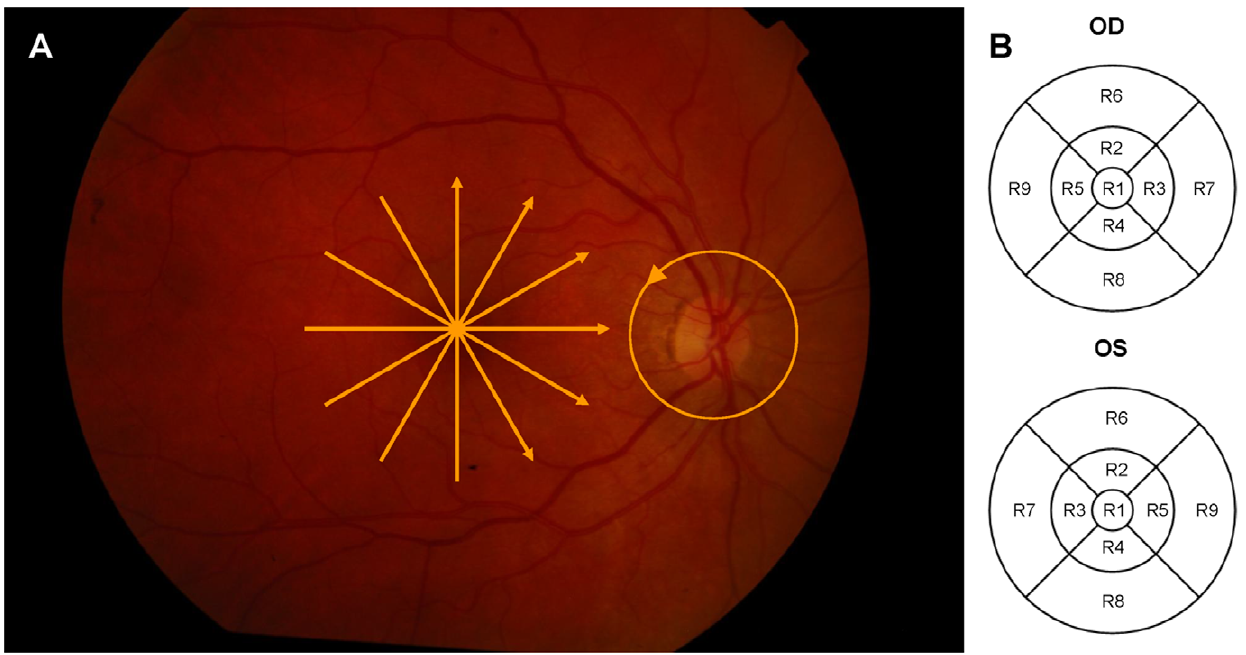
Figure 1. Retinal scanning used in the study. The yellow arrows in the macula and the circle around the optic nerve head show the locations of the OCT scans made. (B) The distribution of ETDRS regions for the right (OD) and left eye (OS).